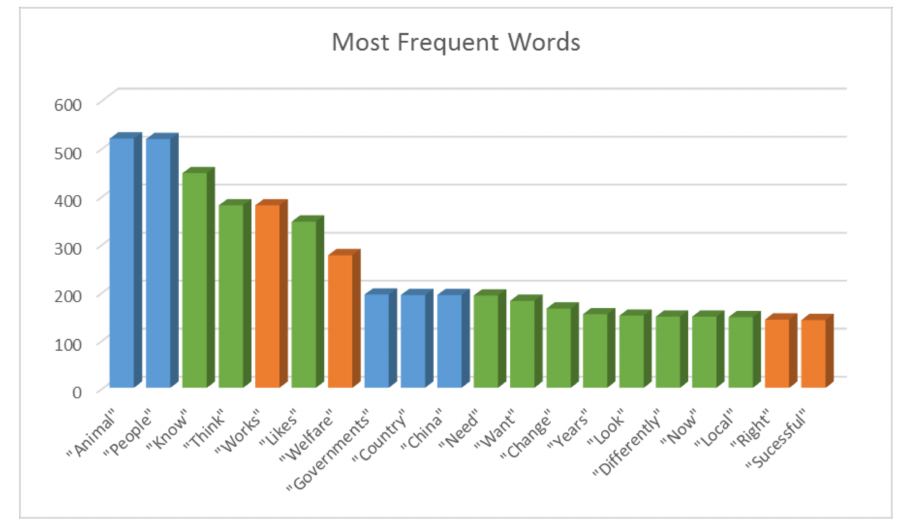
Figure 1. Bar graph visually presenting the 20 most frequent words used by respondents when describing successful international initiatives. Note: Data points are colour coded depending on the context in which they are mostly found; nouns (who) are indicated by blue, instructive actions (how) by green, and outcomes (what) by